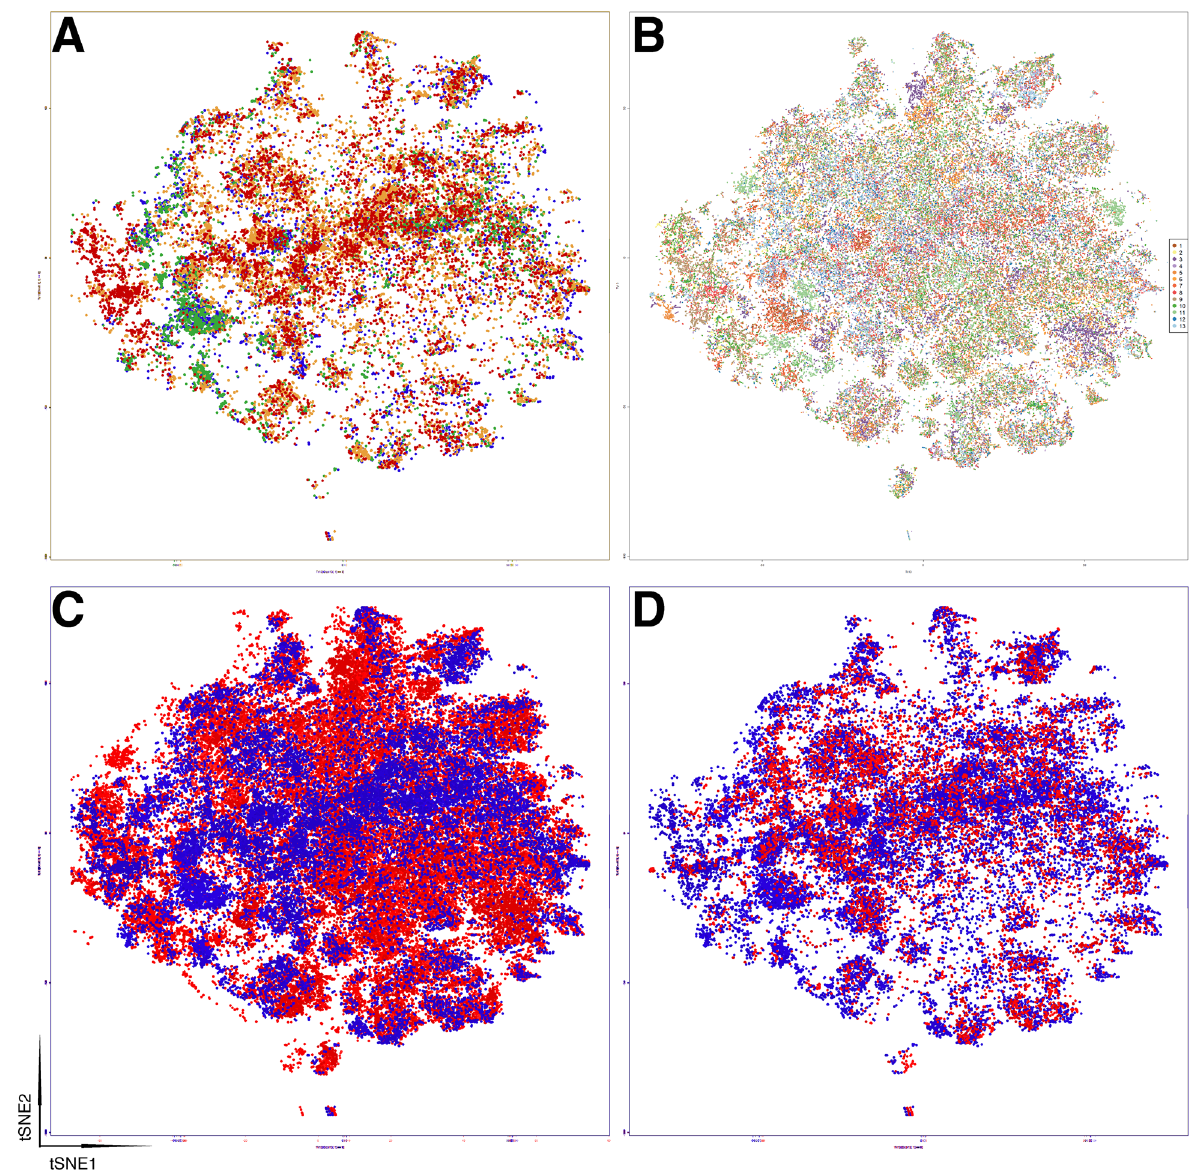
Figure 2. Distribution of control and treated lung cells in dimensionality-reduced 2-dimensional space (tSNE). ( A ) Four saline cases from different time points (7, 14, 21 and 28 days) are plotted according to the tSNE bidimensional coordinates, each in an unique color. Each dot represents a cell. ( B ) tSNE plot of all cases, each with an unique color. ( C ) tSNE plot of all saline samples (blue) and Bleomycin-treated samples at days 7, 14 and 21 (red). ( D ) tSNE plot of all saline samples (blue) and Bleomycin-treated samples at day 28